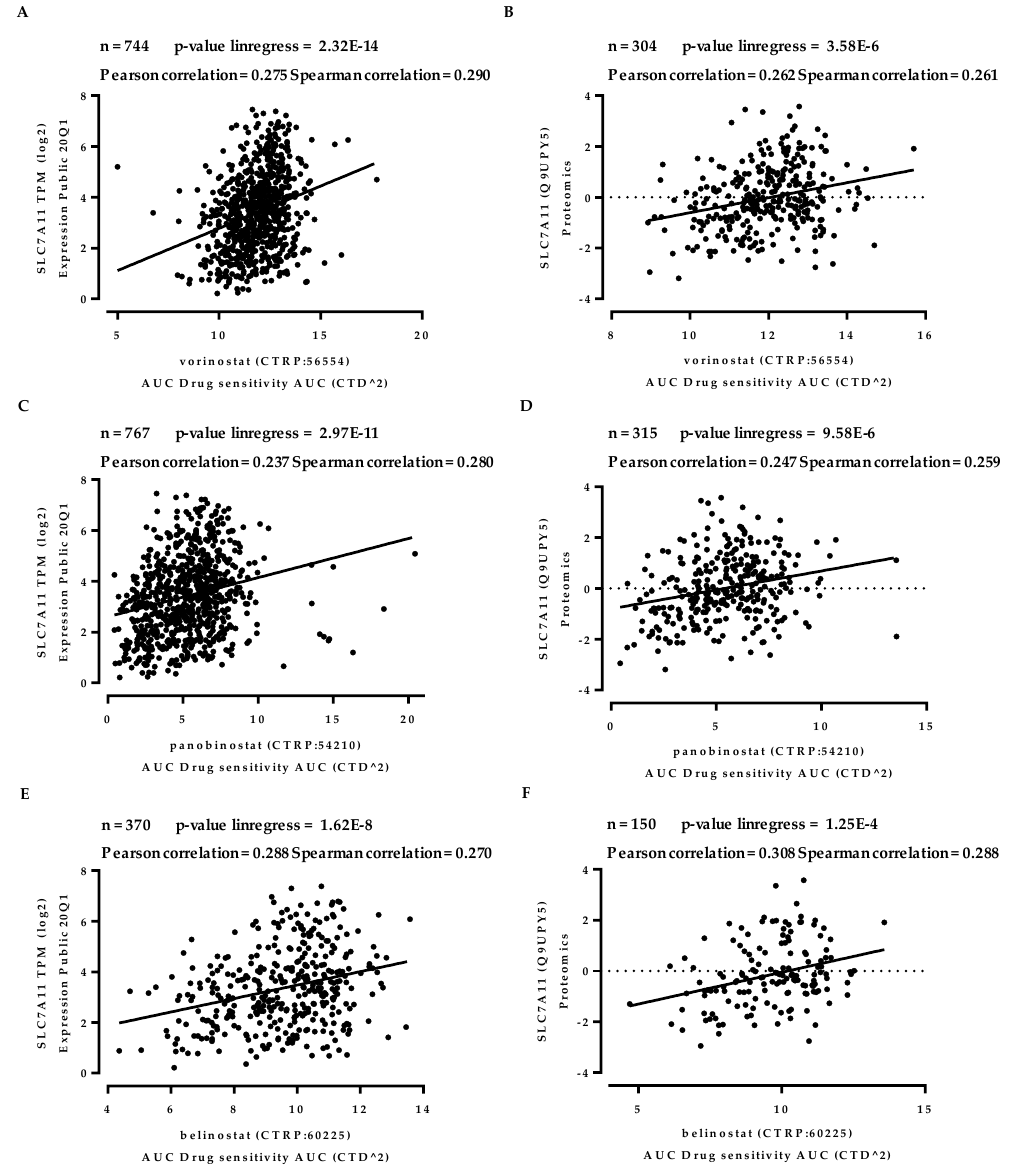
Figure 3. The expression of xCT is modestly but significantly correlated with sensitivity to Histone deacetylase inhibitors (HDACIs). Scatter plots depicting correlation of xCT expression and sensitivity to HDACIs using DepMap analysis. X -axis: the area-under-curve (AUC) of vorinostat ( A , B ), panobinostat ( C , D ), and belinostat ( E , F ) in pan-cancer cell lines. Y -axis: gene expressions of the SLC7A11 gene (coding xCT) normalized transcripts per million, log scale ( A , C , E ) and protein expressions of that, log scale ( B , D , F ).